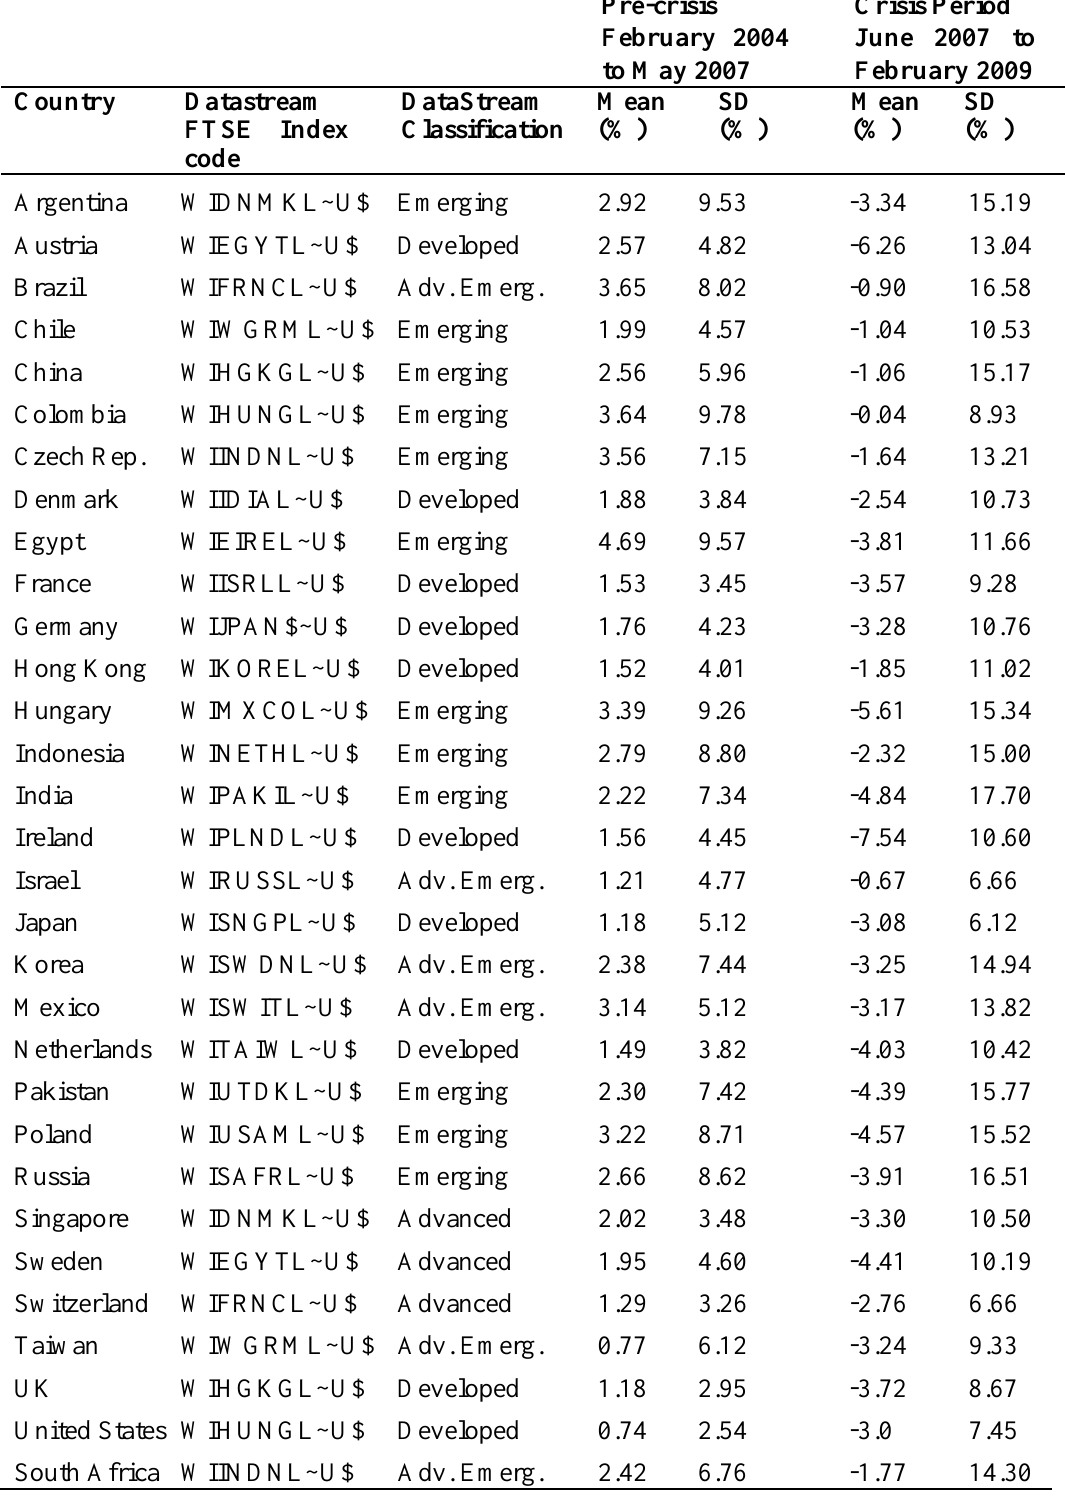
Table 1. Mean Returns and Standard Deviations by